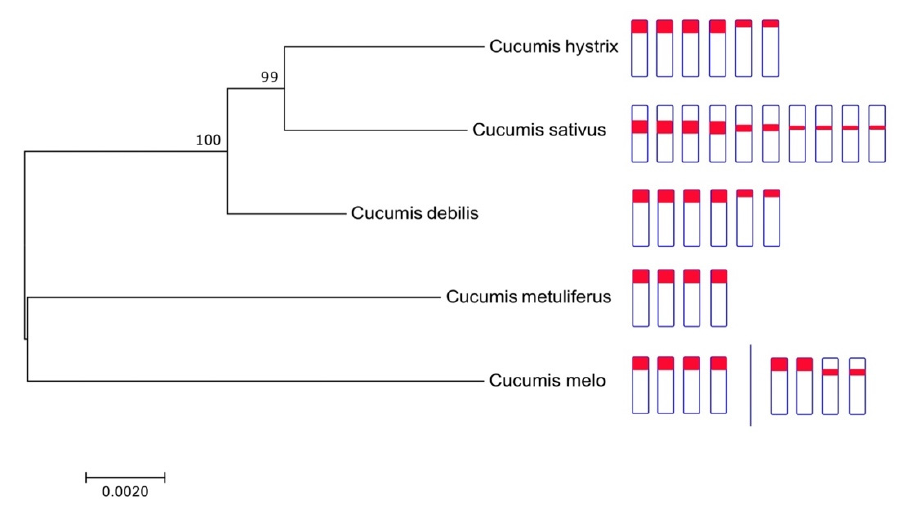
Figure 3. Phylogenetic tree of Cucumis species based on the combined sequences of nuclear internal transcribed spacer (ITS) and chloroplast followed by chromosome ideograms constructed from FISH images. The evolutionary history was inferred by using the maximum likelihood method. The tree with the highest log likelihood ( − 7753.85) is shown. Likelihood bootstrap values are given at the nodes. Evolutionary analyses were conducted in MEGA7.